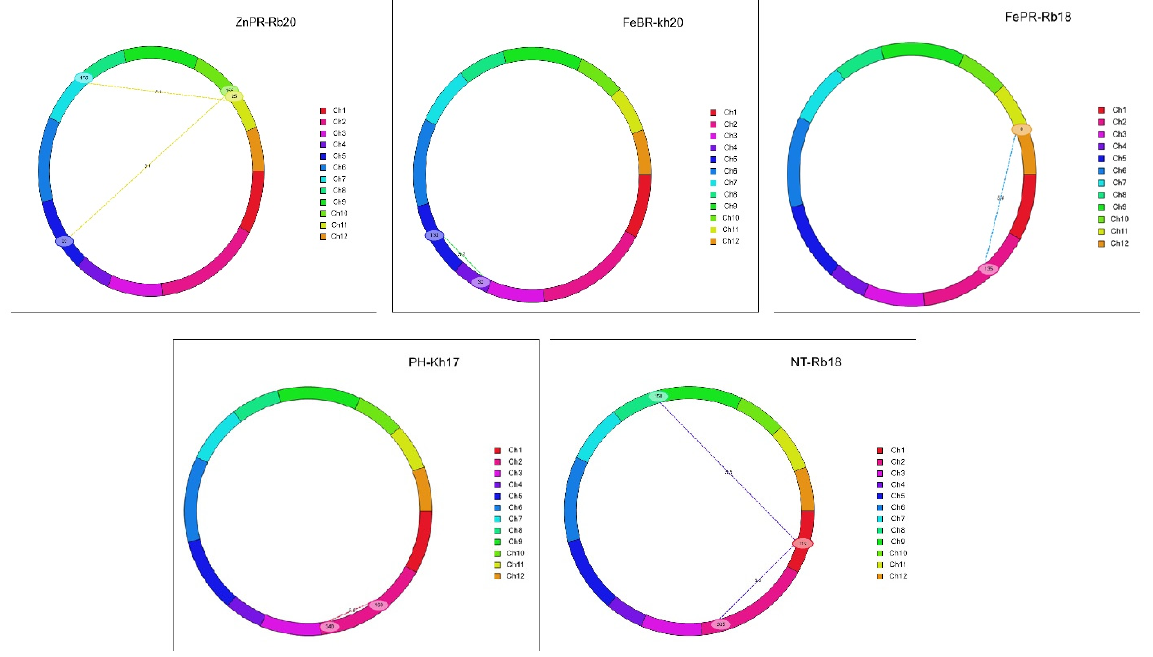
Figure 5. Epistatic interactions in MTU1010 X Ranbir Basmati RIL population using IciMapping